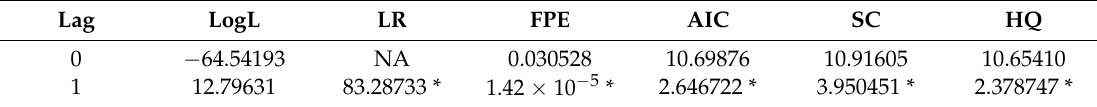
Table 16. Lag selection criteria for non-metal ore mining and processing. Lag LogL LR FPE